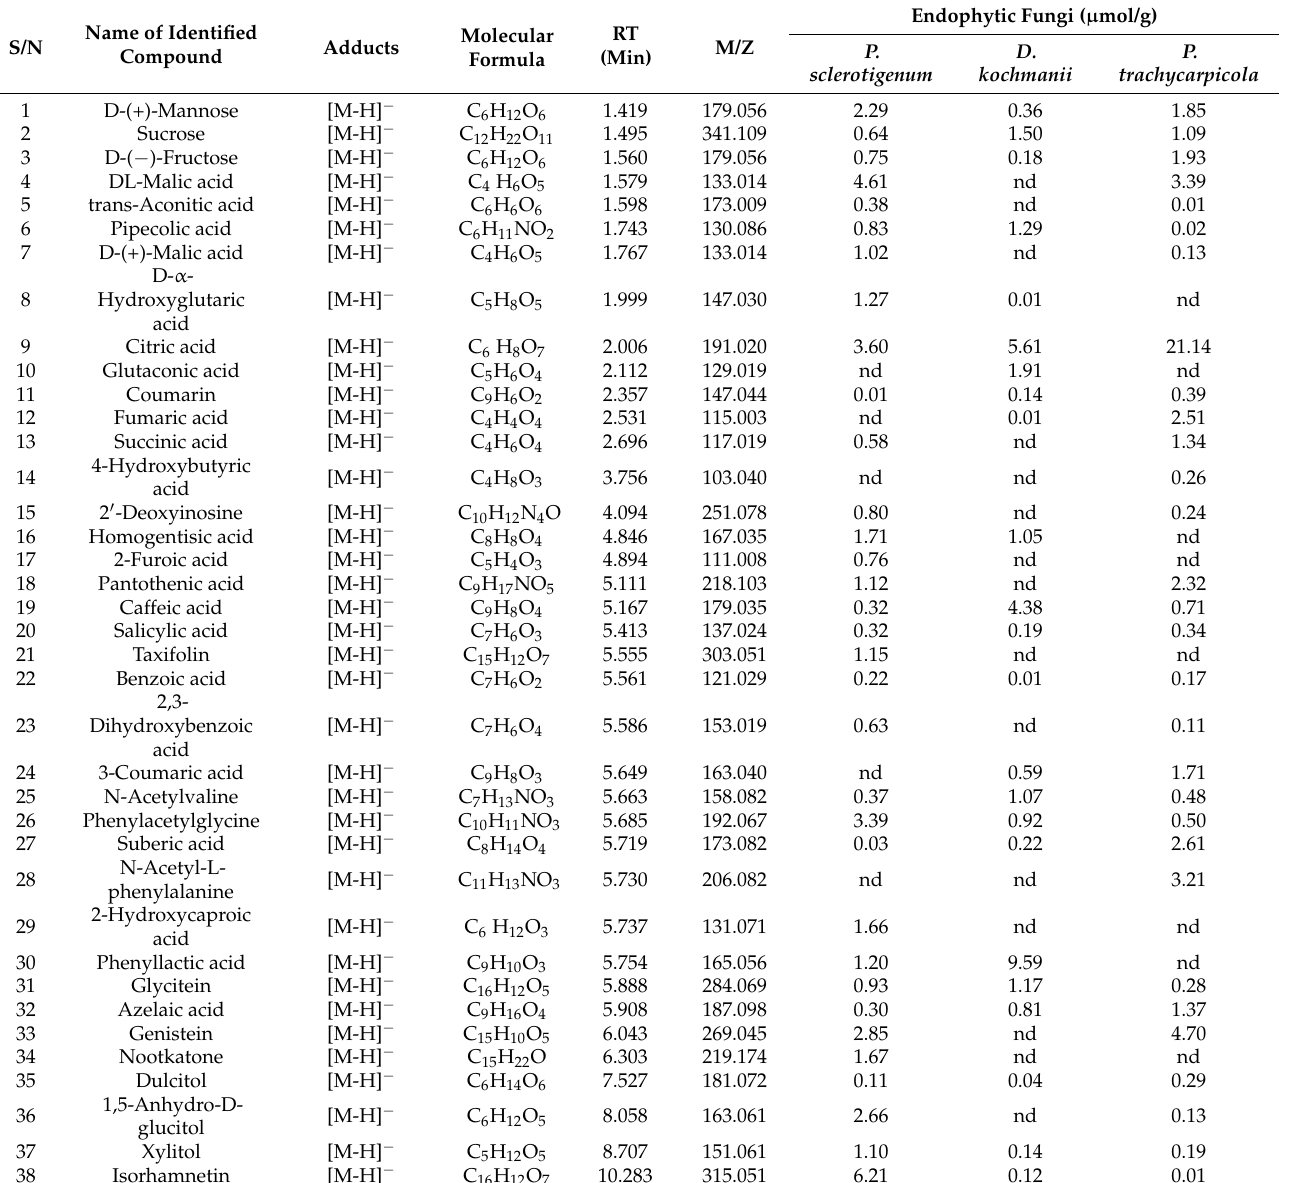
Table 5. Chemical composition of ethyl acetate extracts from endophytic fungi identified via liquid chromatography–tandem mass